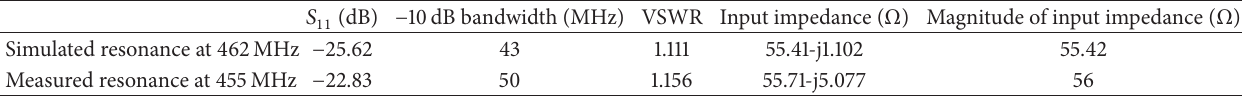
Table 1: Comparison between simulations and measurements for the designed fractal antenna.